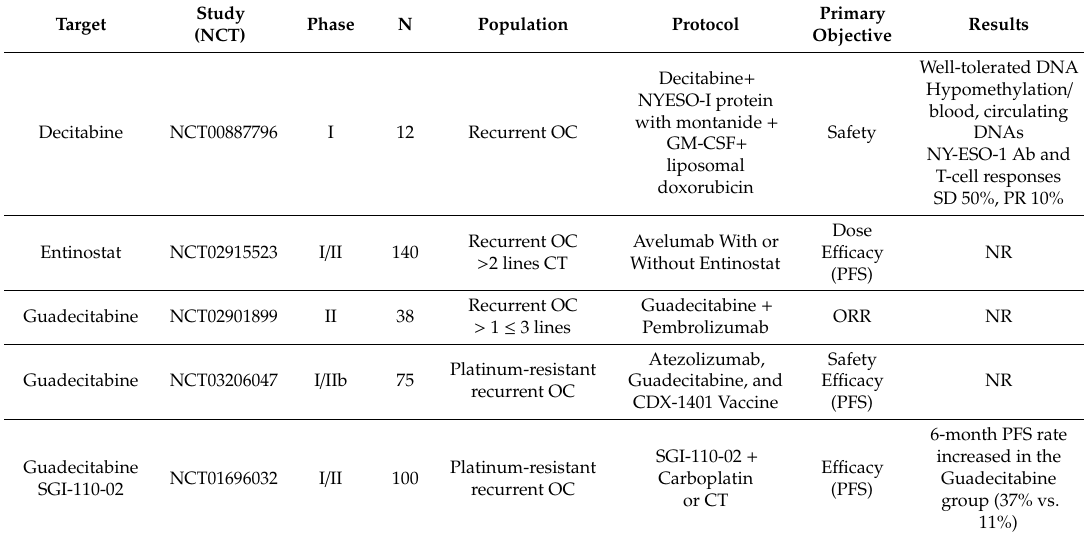
Table 5. Clinical trials with agents targeting